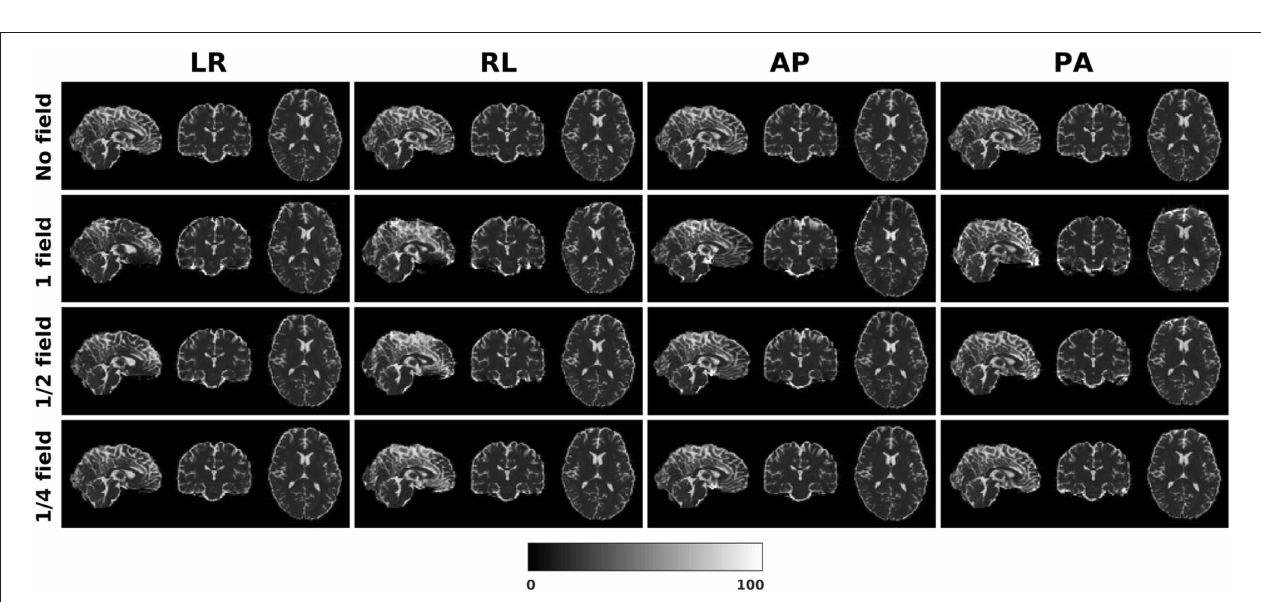
FIGURE 2 | Three levels of susceptibility distortion were simulated. 1 field is the original fieldmap. 1/2 field is the original fieldmap divided by 2. 1/4 field is the original fieldmap divided by 4.